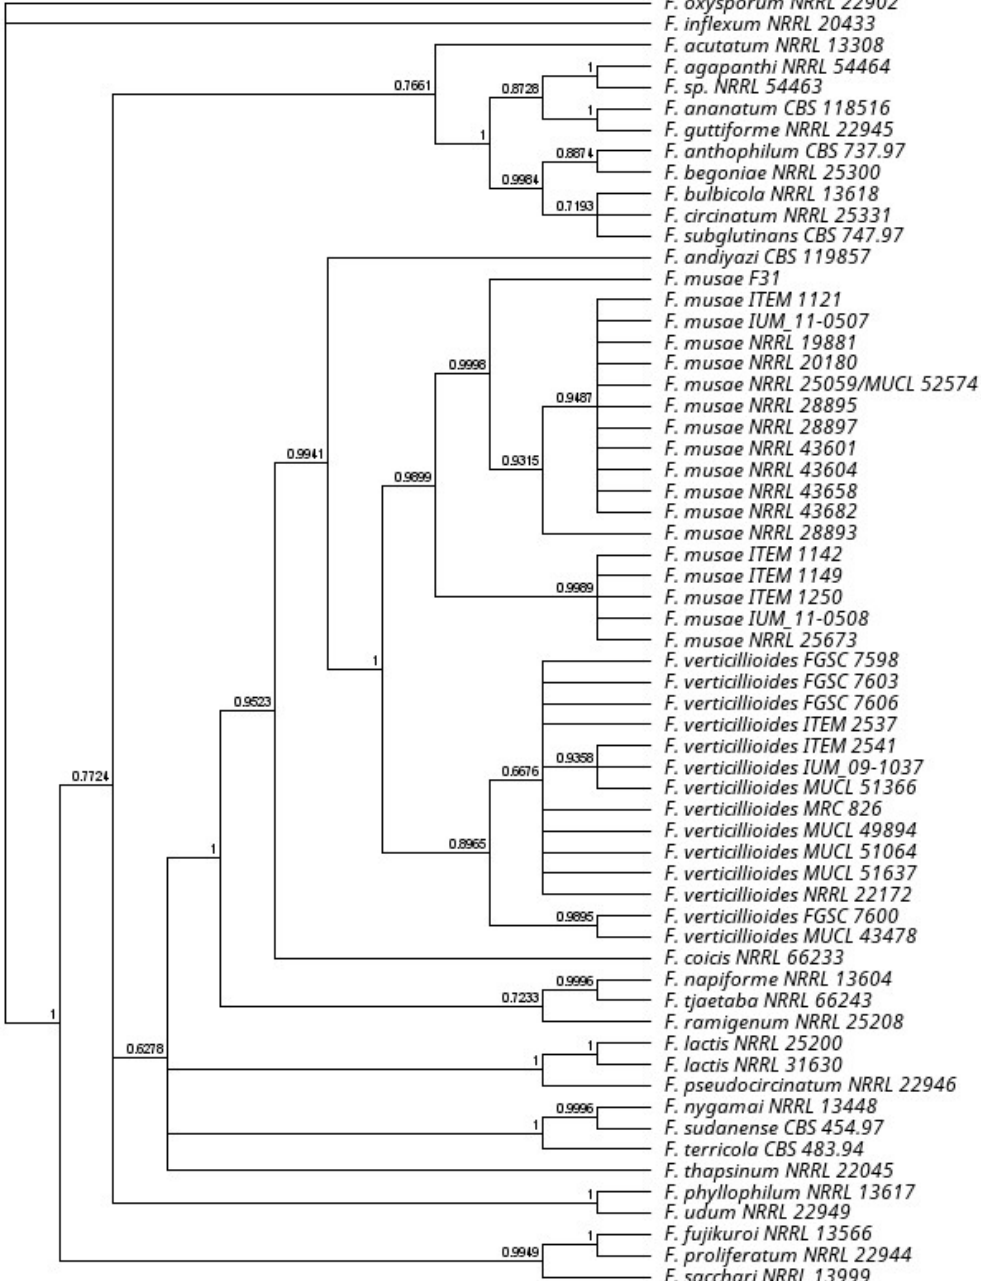
Figure 1. Phylogenetic tree position F. musae strains on a Fusarium tree based on EF1 and RPB2 sequence diversity. Bayesian posterior probability tree obtained with mr.Bayes plugin in the Geneious software. Branch labels are shown as a measure in support of the nodes.